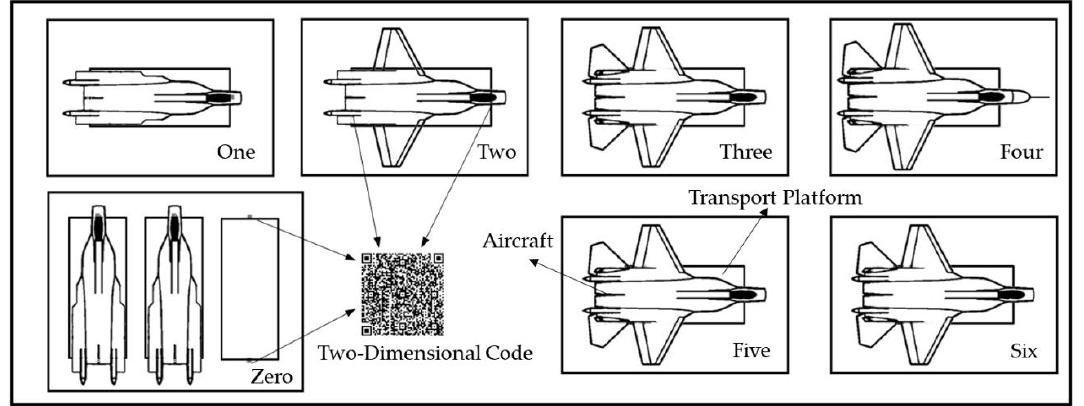
Figure 4. Example of aircraft pulse final assembly line.